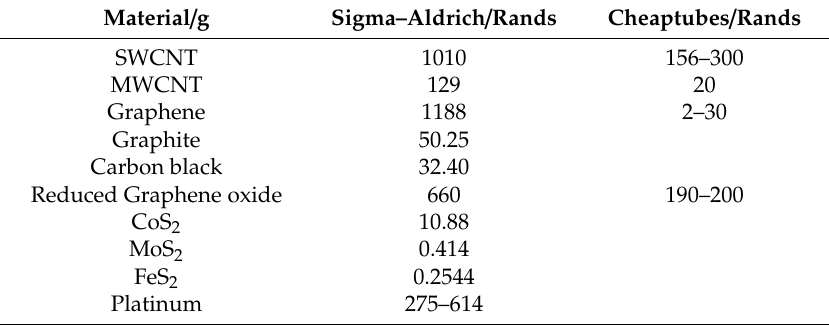
Table 4. Prices of metallic sulphides and carbon-based